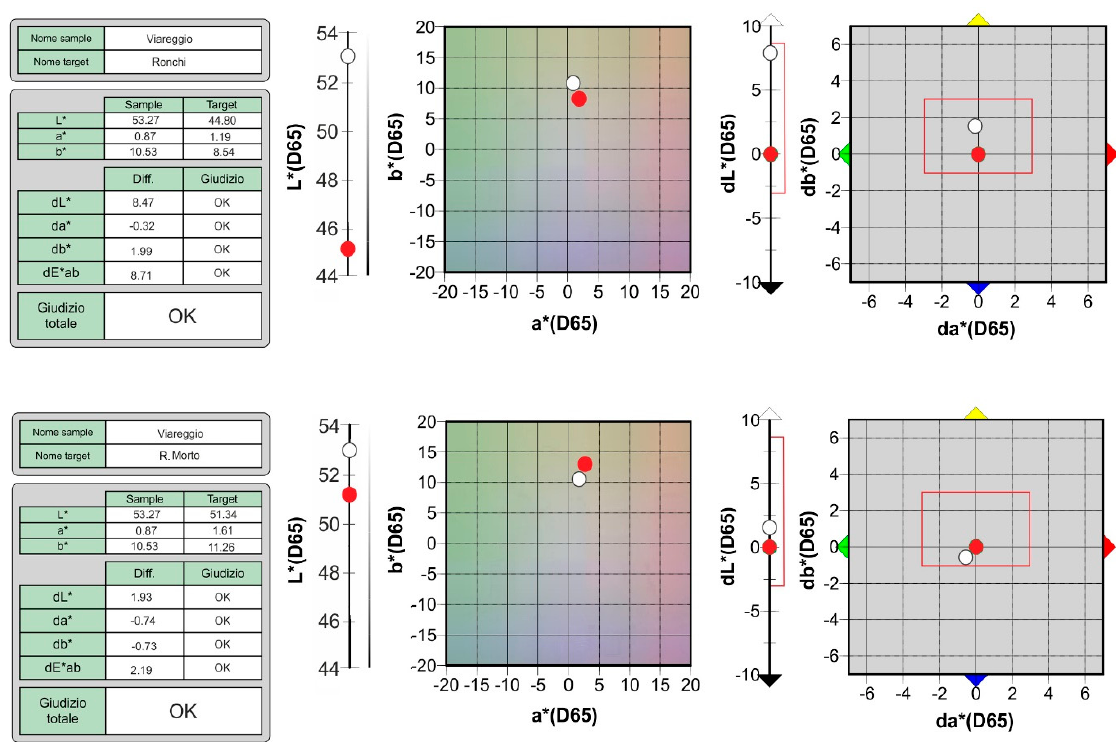
Figure 7. Colour compatibility of Viareggio sand with that of the Ronchi beach (Sector 5) and of R. Morto beach (Sector 12). Acceptability range is delimited in red on dL* axis, with a red rectangle on a*, b* plain. Left graph shows L* and a*b* absolute values of native (withe dot) and borrowed (red dot) sediments; the graphs on the right show the distance of borrowed sediments from native ones.